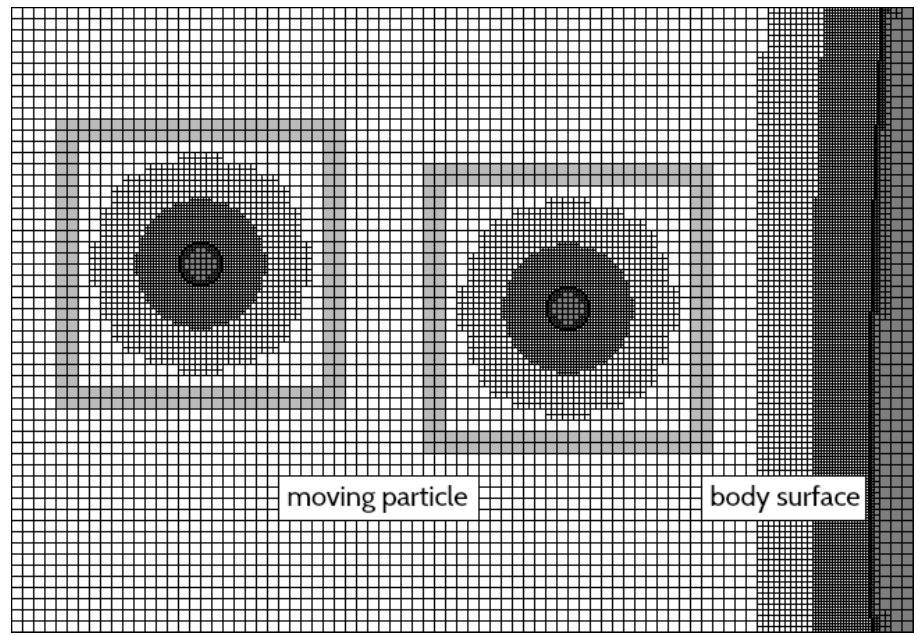
Figure 2. Sliding grids.